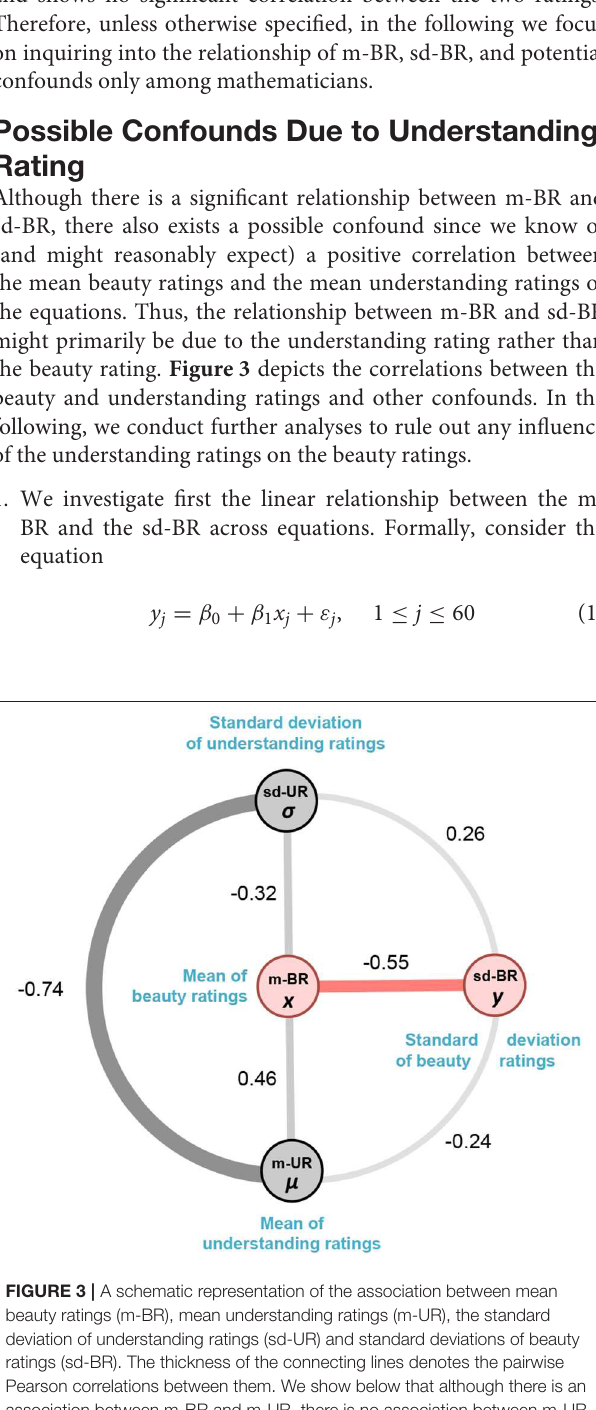
FIGURE 4 | A graph relating the standard deviation of the pre-scan beauty ratings (sd-BR) against mean understanding ratings (m-UR) for each equation (Pearson r : 0.24, p > 0.05). Conventions as in Figure 2 −